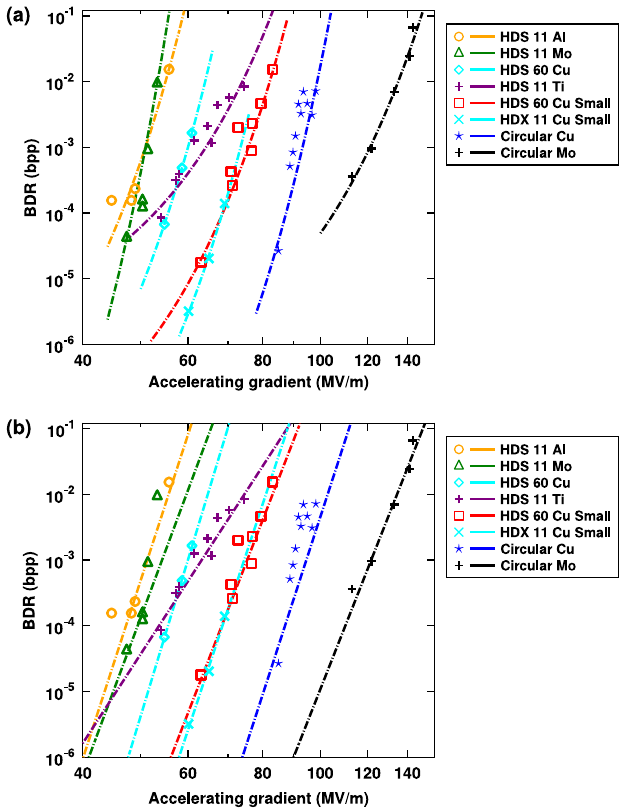
FIG. 3. (a) Measured dependences of R (in units of break- BD down per pulse, bpp) versus electric field for different accelerat- ing structures and fits of the model to the data. For clarity, the results of the functional fit are not shown for all E values for all data sets. (b) Fits of power law functions to the same data. The experimental data and their labels are from